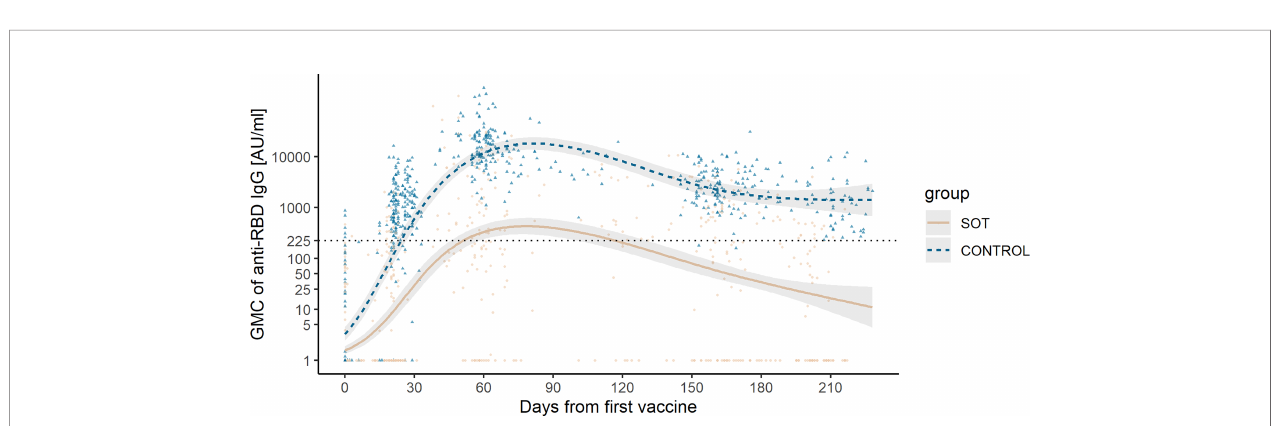
FIGURE 1 | Observed anti-receptor-binding domain (RBD) immunoglobulin G (IgG) concentrations and predicted geometric mean concentration (GMC) of anti-RBD in solid organ transplant (SOT) recipients and controls. Development in predicted GMC of anti-RBD IgG represented in AU/ml plotted on top of the observed individual concentration of anti-RBD IgG at each sample time from SOT recipients (yellow) and controls (blue). The dashed horizontal line indicates the minimum threshold for positive humoral response.